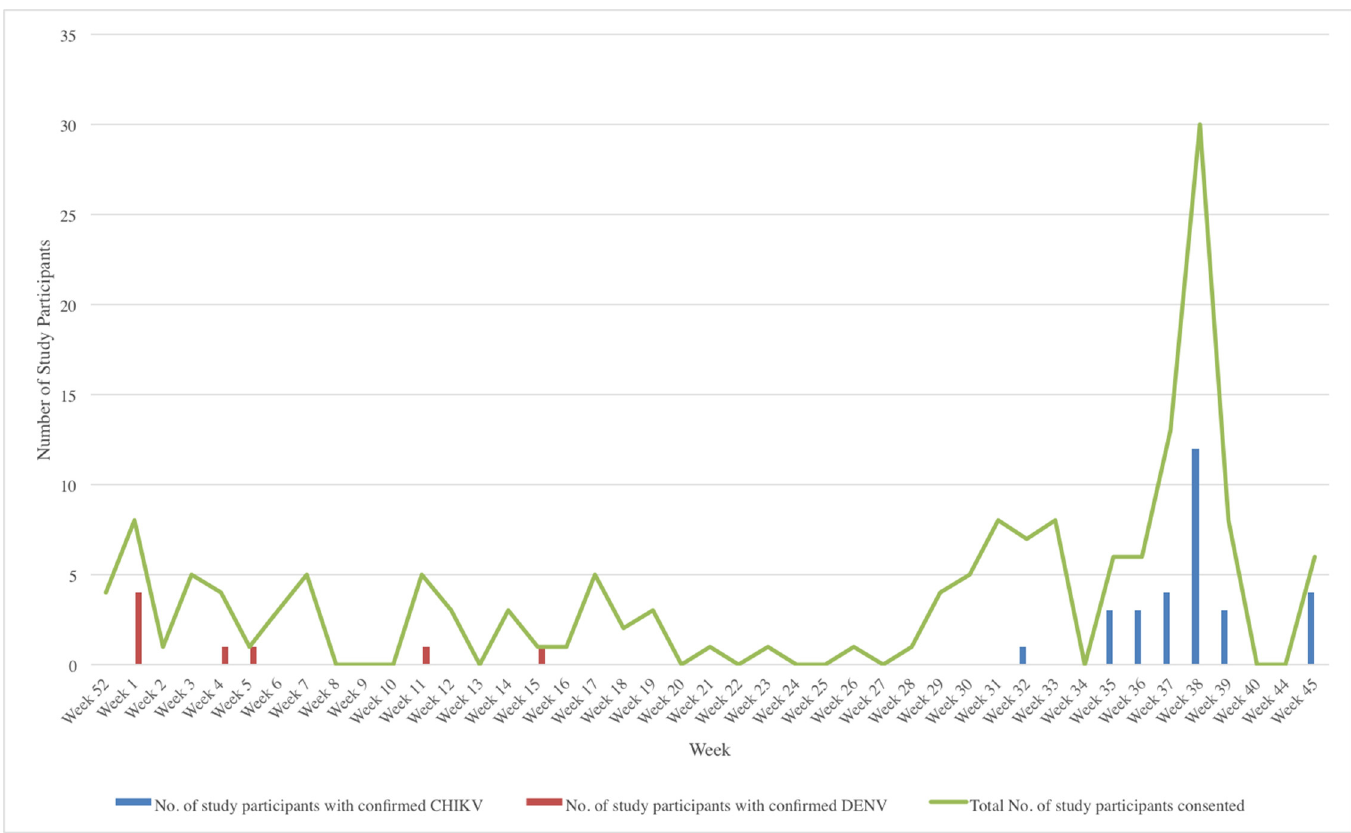
Fig 1. Total number of patients enrolled and number of CHIKV and DENV RT-qPCR positive cases by week. The green line graph indicates the number of patients enrolled per week. Histogram bars indicate the number of individuals confirmed as RT-qPCR positive for CHIKV (blue) or DENV (red) by RT-qPCR. Weeks 41 – 43 in 2014 are excluded as no patient enrolment was attempted during this